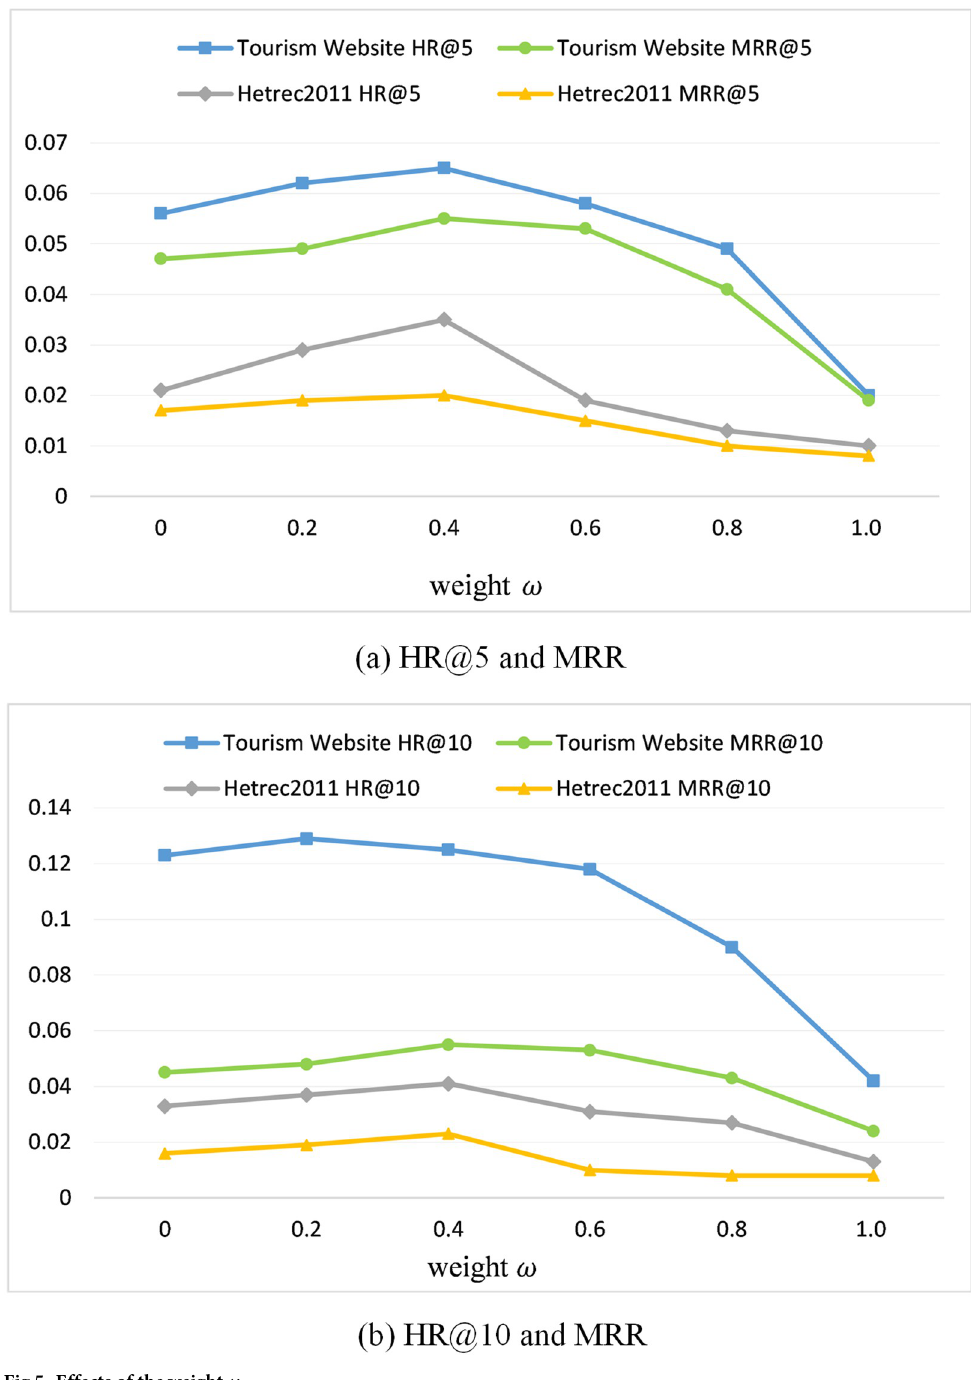
Fig 5. Effects of the weight ω